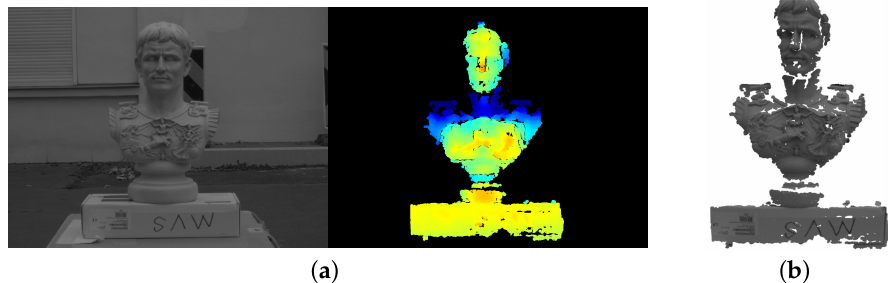
Figure 18. The aligned RGB-D image pair ( a ) after preprocessing as well as the generated colorized point cloud ( b ) from this pair. This point cloud is utilized by an ICP registration process for a coarse alignment, which is then be refined using the RANSAC PnP tracking module implemented in [22] that takes the RGB-D pair as input.